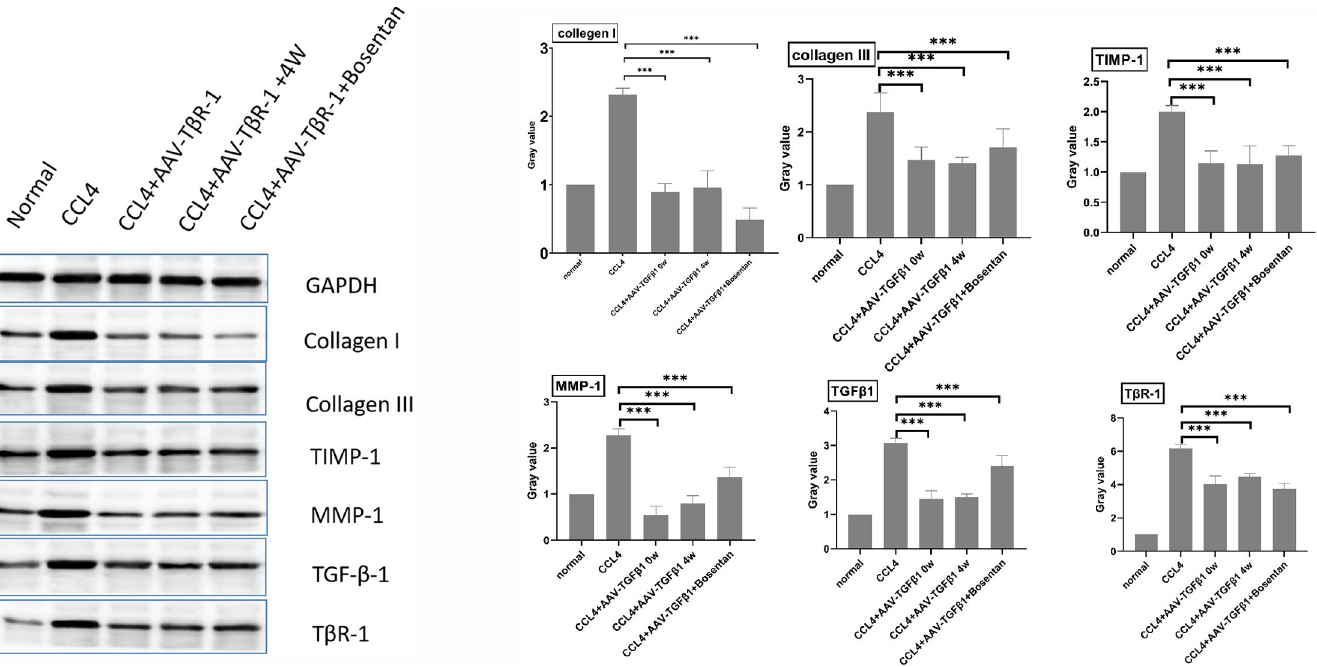
Fig 3. Results of western blotting of the different